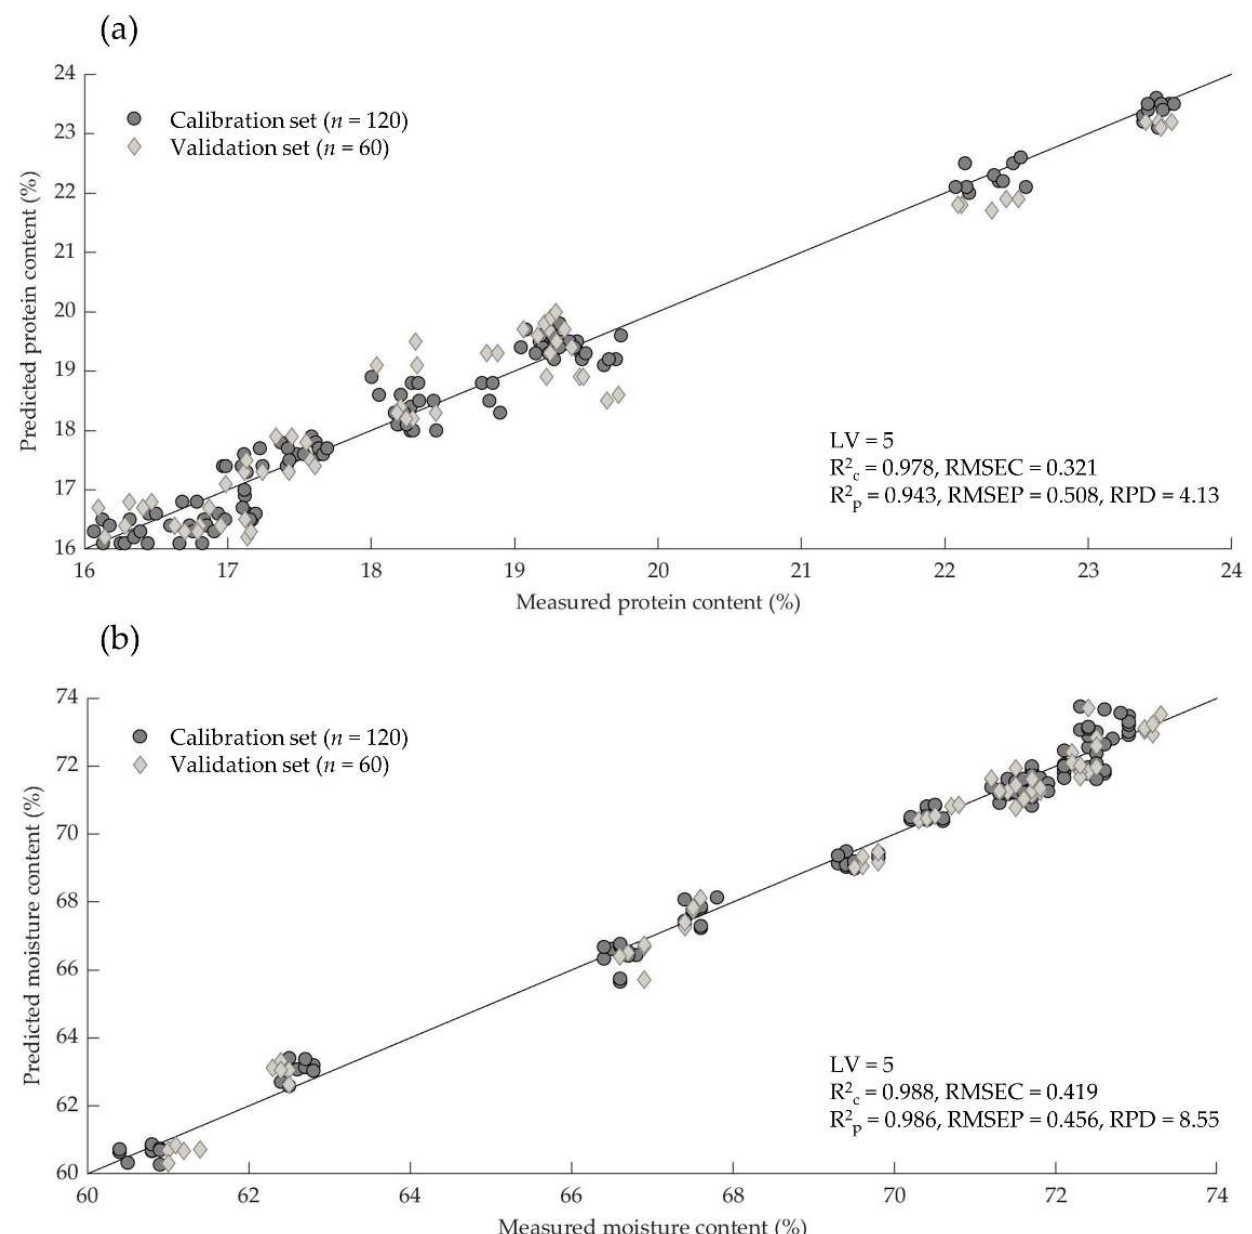
Figure 2. Comparison of measured and predicted values of protein ( a ) and moisture ( b ) content of living mealworm larvae in calibration and validation sets by NIRS (1100–2100 nm).